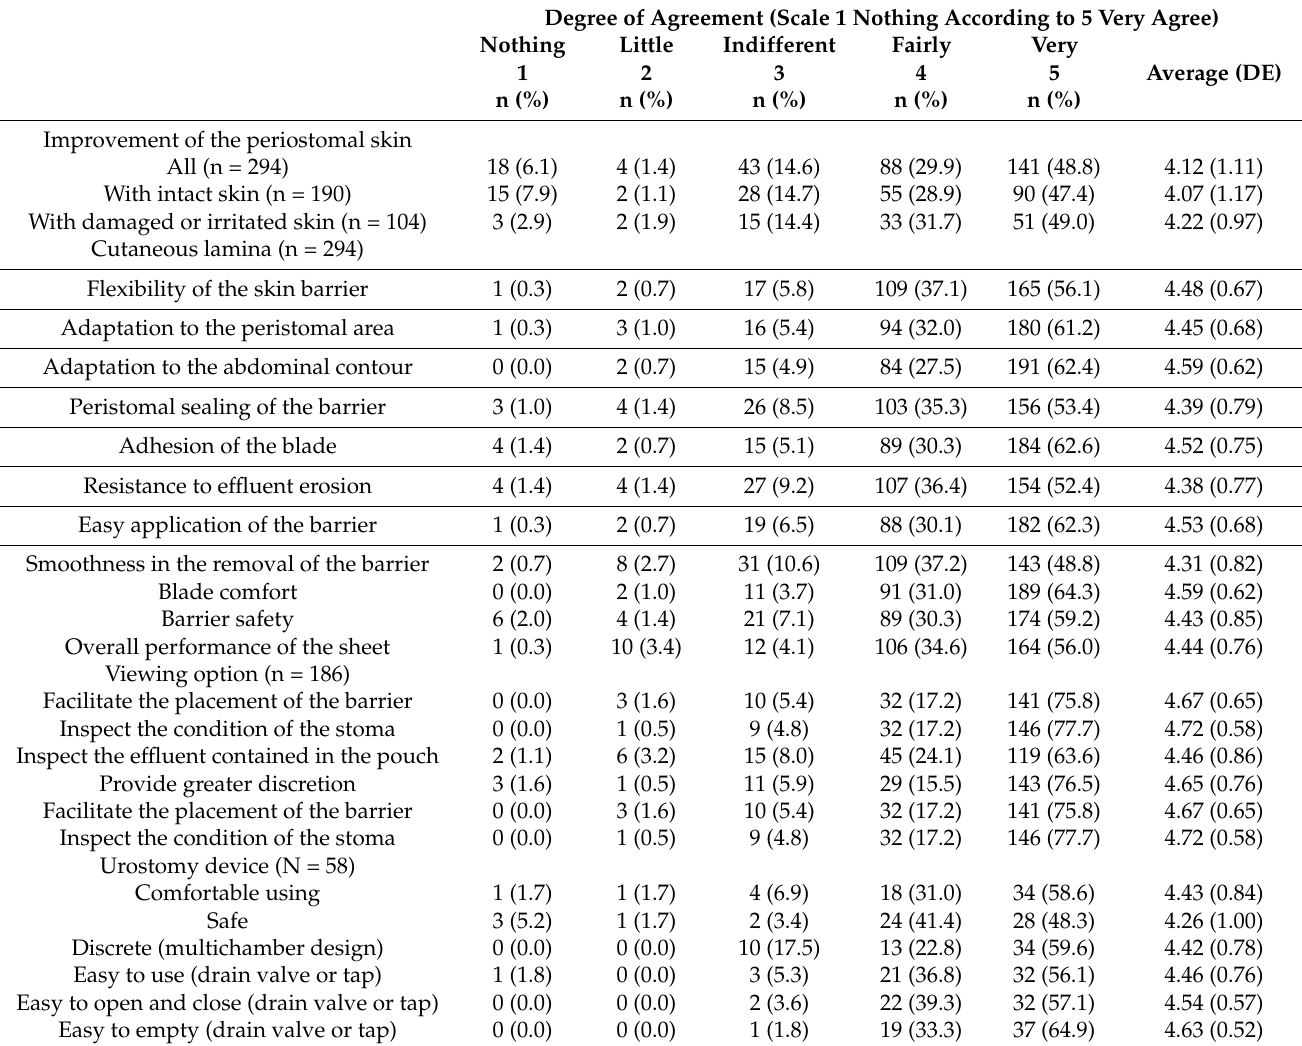
Table 4. Evaluation of the improvement, adverse events, and foil and display window after the use of the